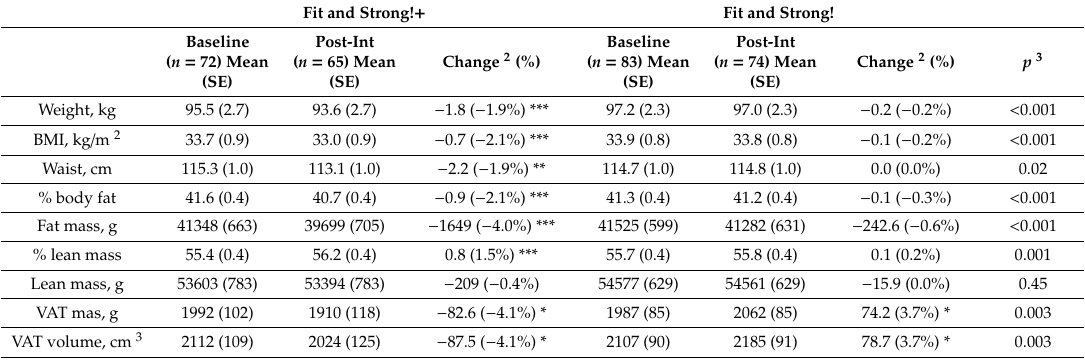
Table 2. Anthropometrics and body composition: adjusted 1 means at baseline and post-intervention visits. Fit and Strong! +